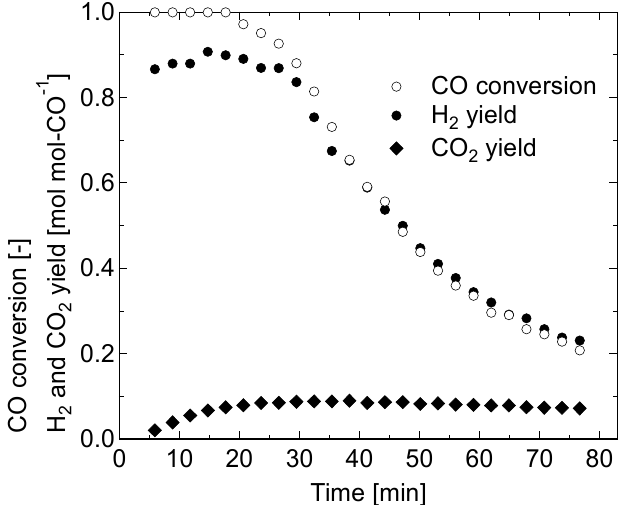
O (3 wt% Au, calcined at 200 °C) 2 3 O/N = 2.2/30.3/67.5%, GHSV = 2800 h − 1 2 2